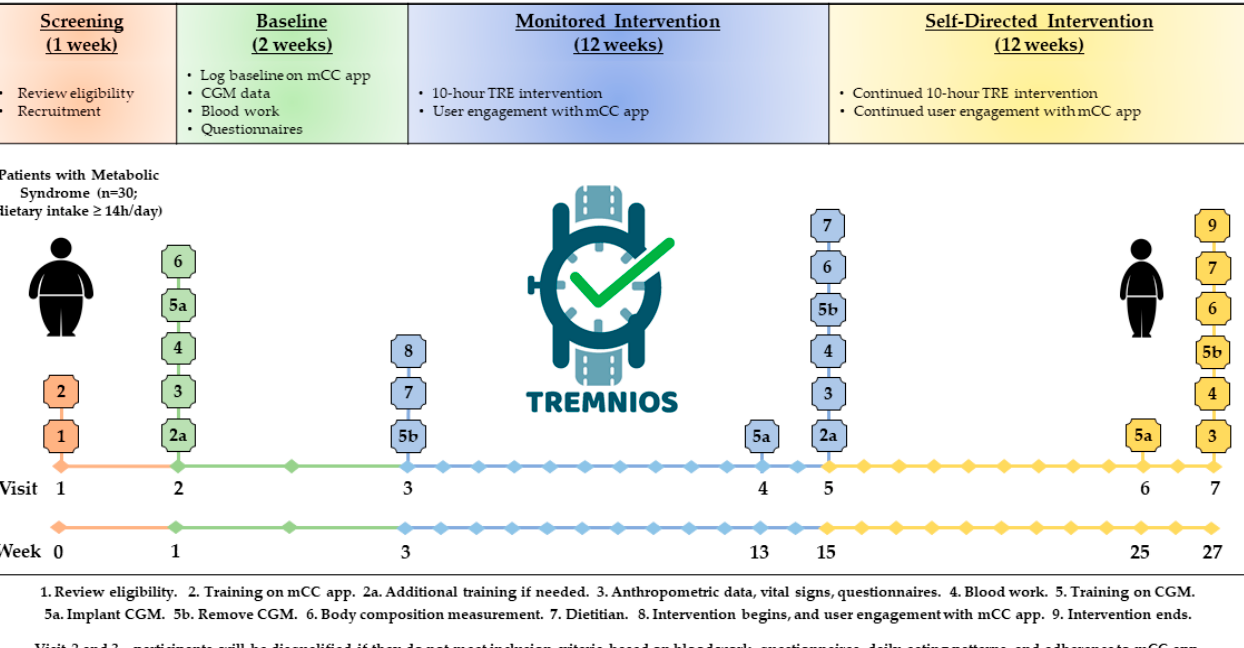
Figure 1. Study Figure 1. Study design.